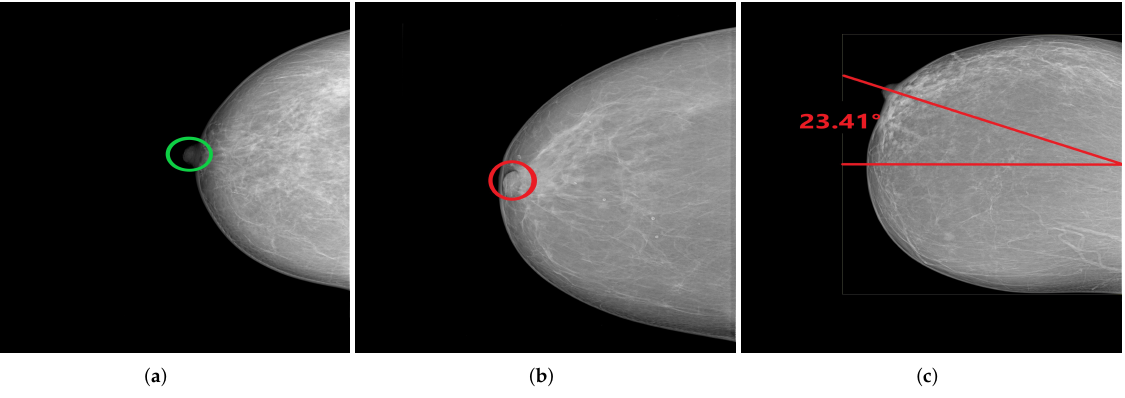
Figure 28. CC views with well-positioned nipple ( a ) and inadequately positioned nipple ( b , c ). ( a ) Nipple in profile; ( b ) Nipple on retromammary tissue; ( c ) Nipple deviated by 23.41°